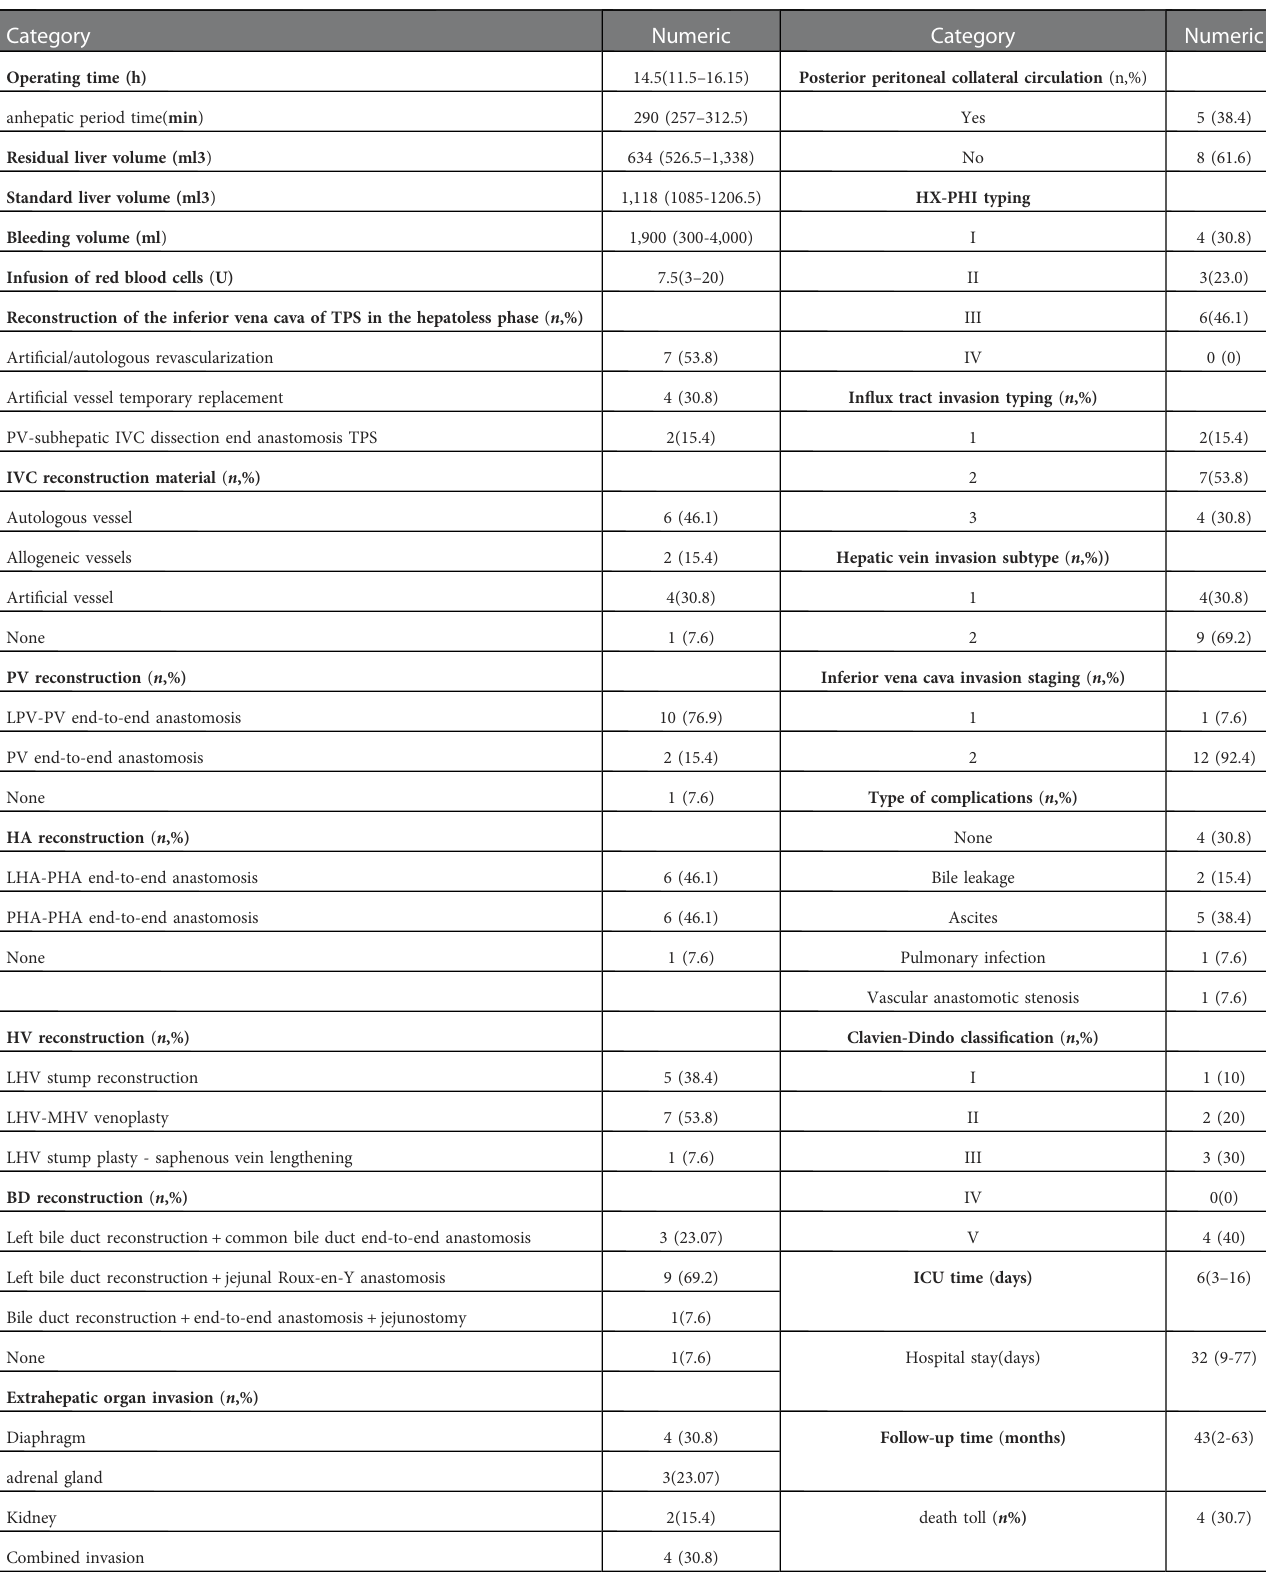
TABLE 1 Intraoperative information and postoperative outcomes of 13 ELRA